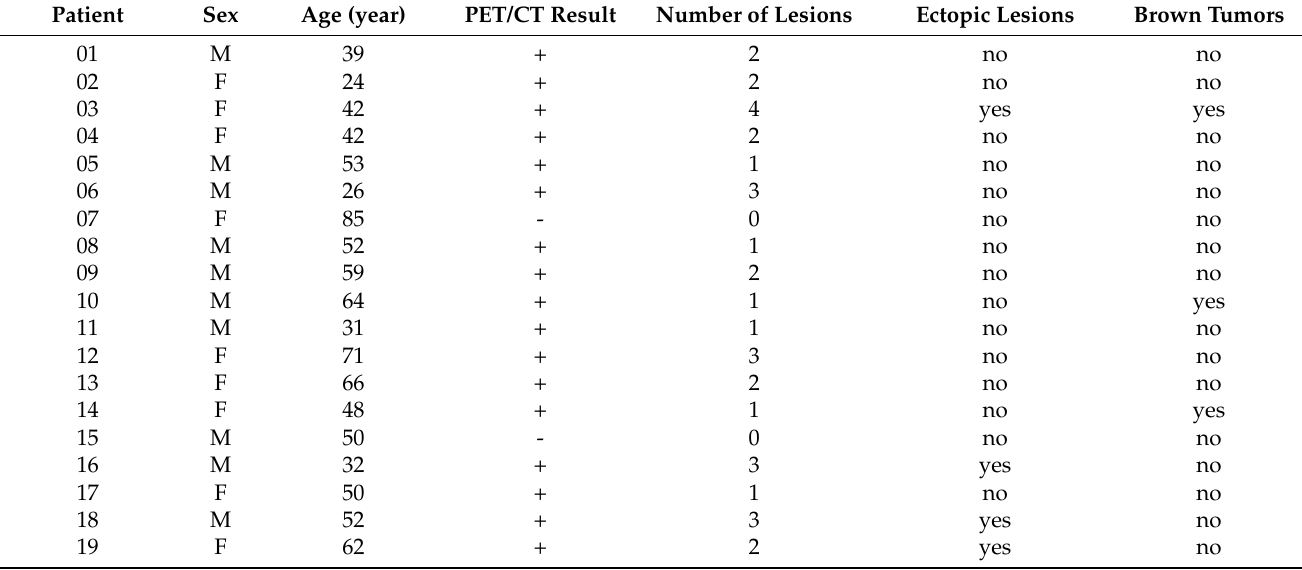
Table 1. PET/CT with [ 11 C]MET